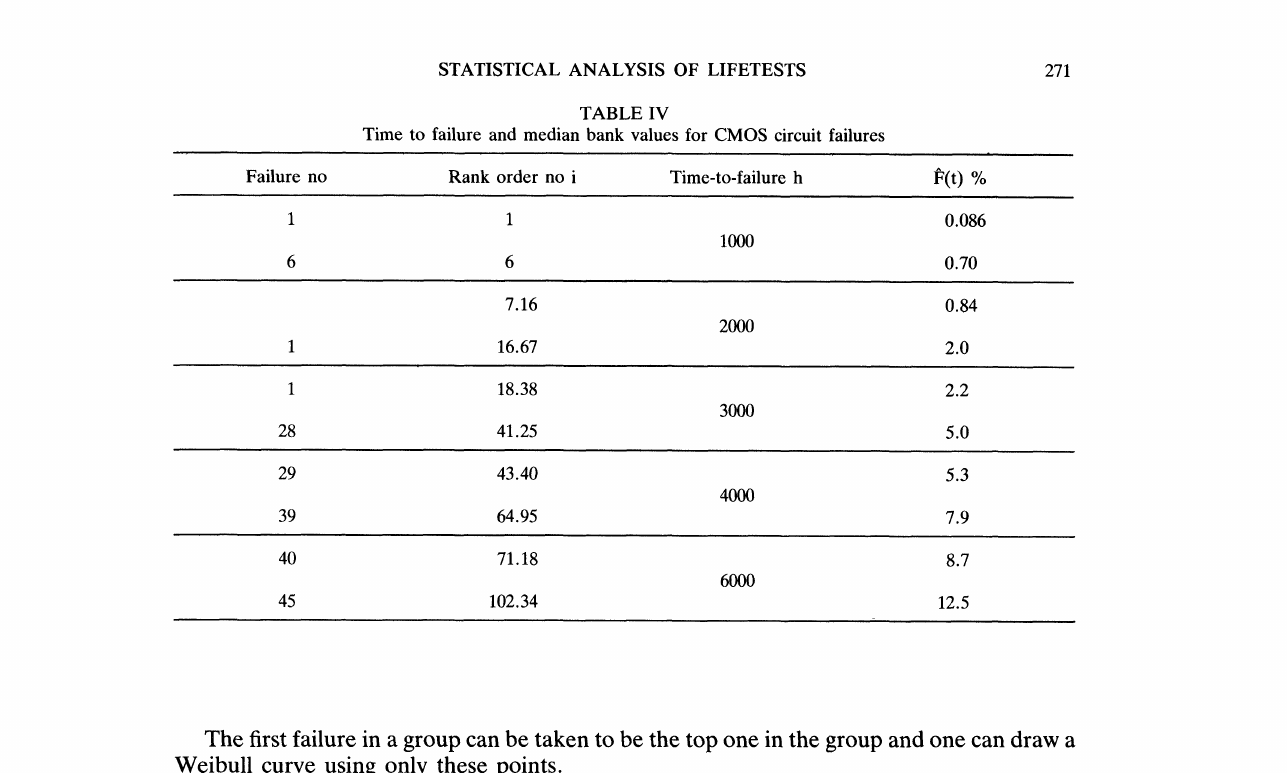
TABLE IV Time to failure and median bank values for CMOS circuit